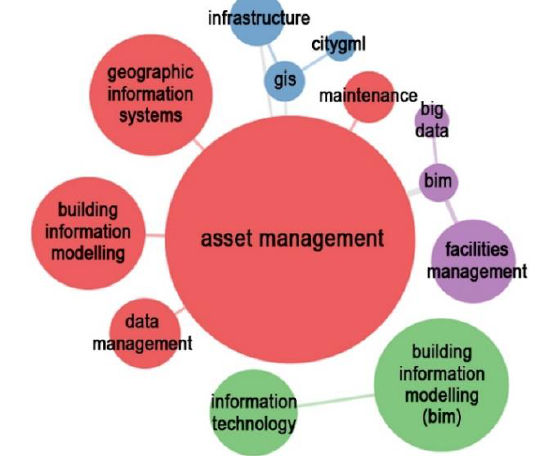
Figure 4. Keywords co-occurrence network (WoS database) Social structure (Figure 5) was analysed through the countries’